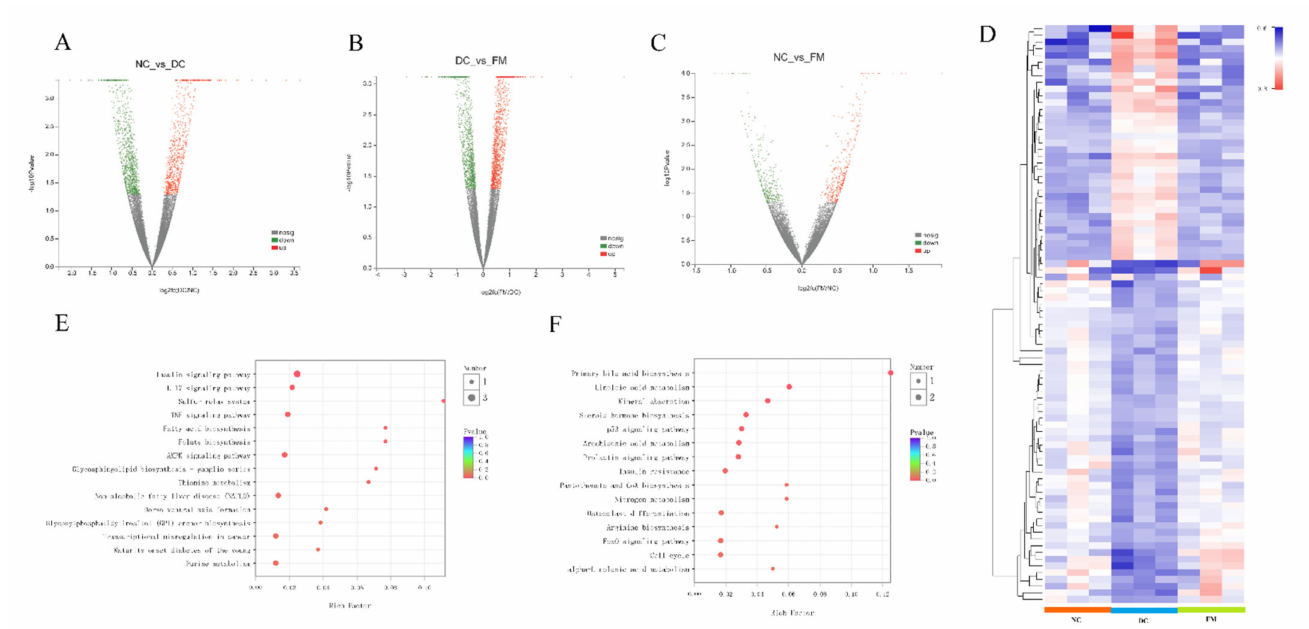
Figure 4. Effect of foxtail millet supplementation on liver transcriptomic profiles: ( A – C ) differentially expressed genes (DEGs) between different groups; ( D ) heatmap of 86 shared DEGs; ( E ) signaling pathways involved in upregulated DEGs; ( F ) signaling pathways involved in downregulated DEGs. NC, normal control group; DC, diabetic control group; FM, foxtail millet supplementation